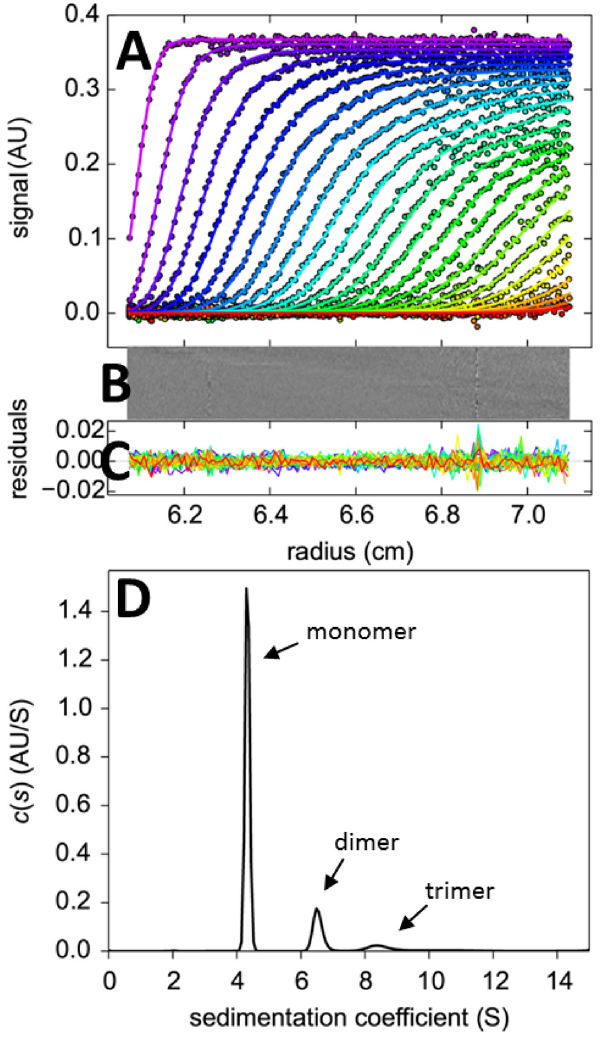
temperature. (B and C) Bitmap and overlay of the residuals of the fit. (D) c ( s ) sedimentation coefficient distribution showing peaks for monomer, dimer, trimer, and traces of higher